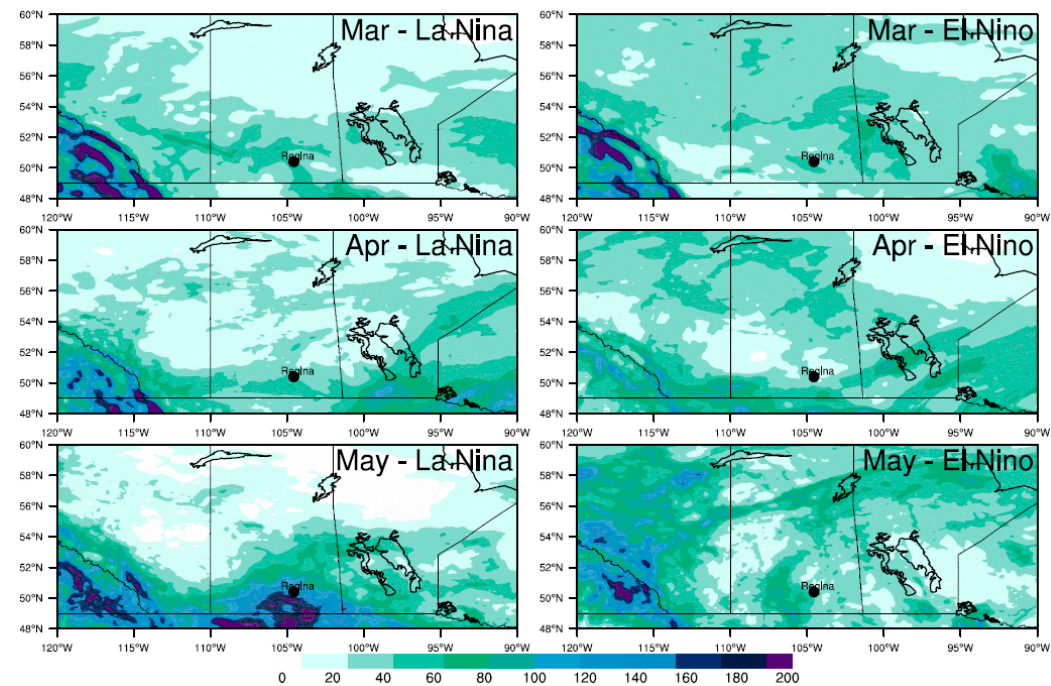
Figure 4. WRF simulated total precipitation (mm) for spring (March, April, and May) during the La Niña of 2010–2011 and El Niño of 2015–2016.